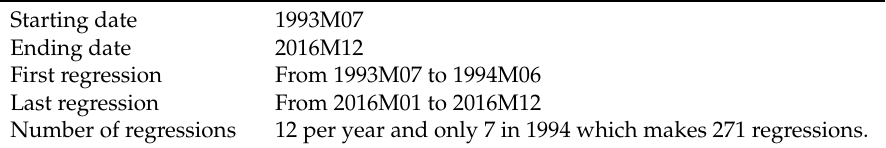
Table 5. Rolling regression parameters. Source: created by Authors.